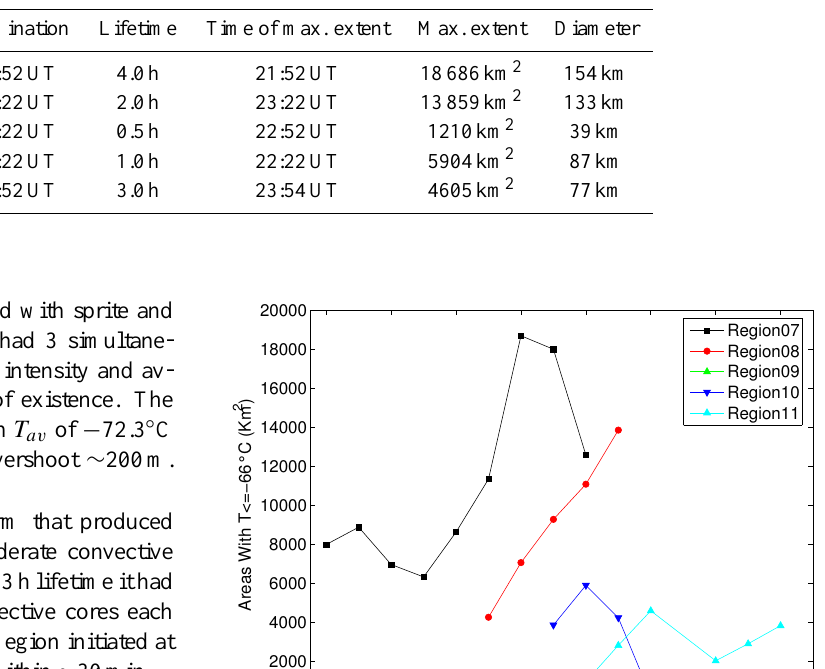
Regions 1, 4 and 10 were within this limitation range. Re- gions 5 and 6 were the only ones close enough to the network to have a detection efficiency ≥